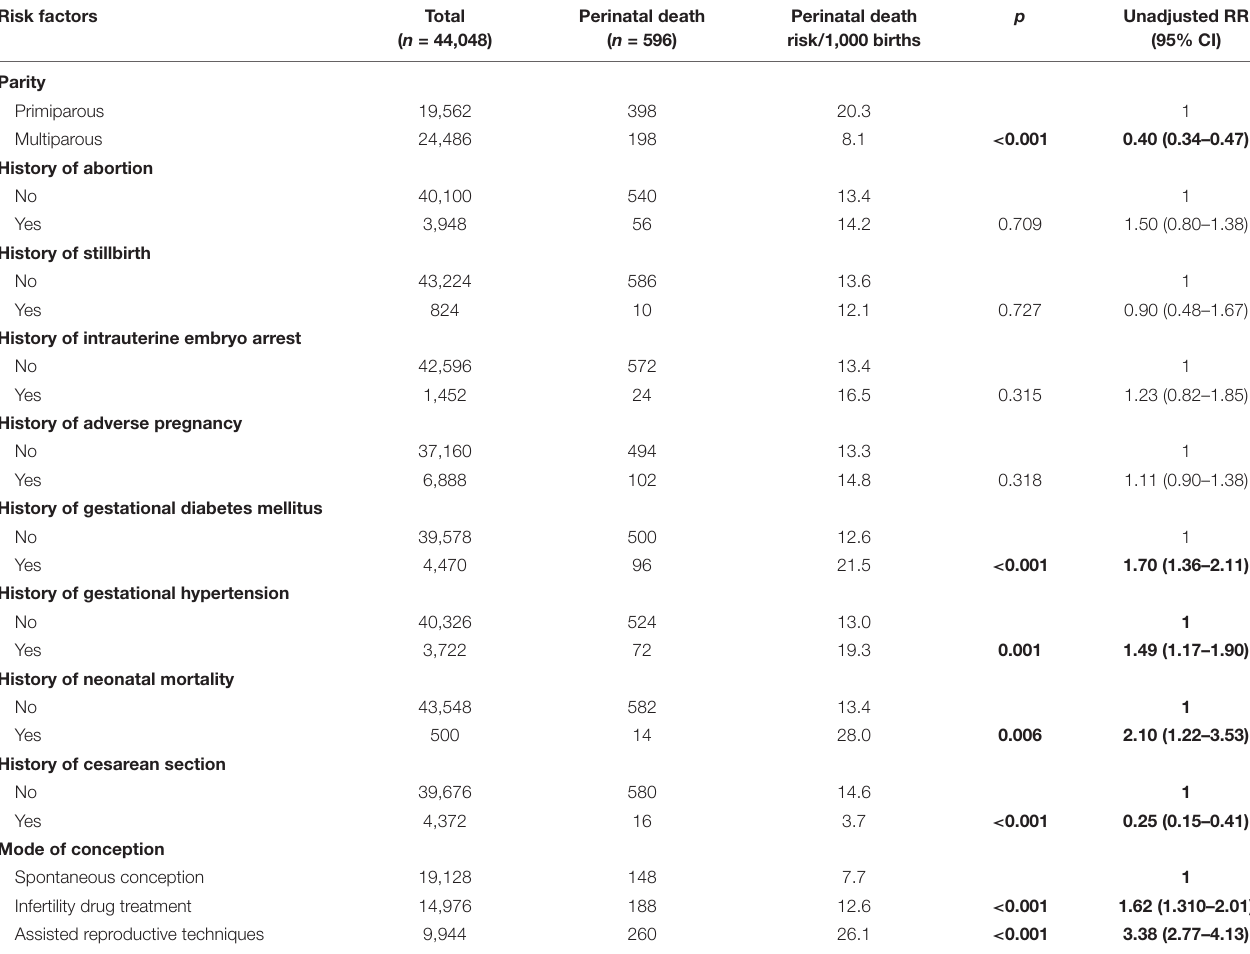
TABLE 2 | Maternal history and unadjusted relative risk (RR) for perinatal death among 44,048 pregnant women. Risk